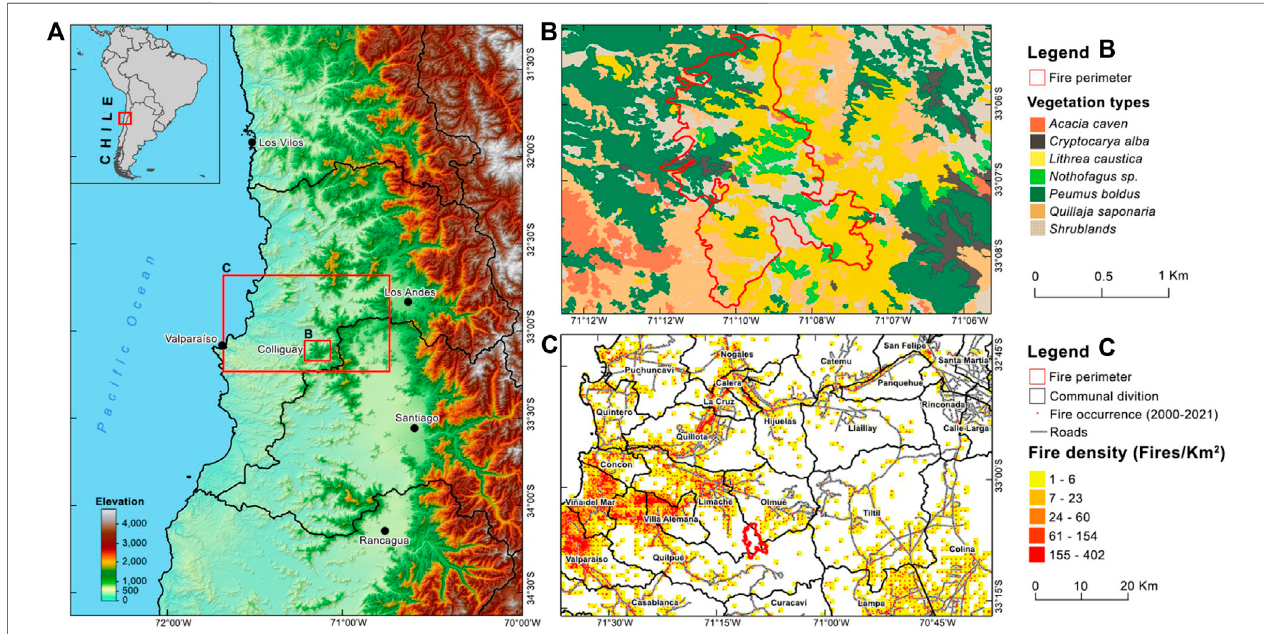
FIGURE1| Studyarea. (A) CentralChileandthegenerallocationoftheColliguaywild fi re(redpolygon)wheretheproposedapproachisapplied; (B) speci fi careaof the Colliguay wild fi re and vegetation types before the event(May 2020); (C) context ofhigh density ofwild fi res in thesurrounding areas oftheColliguay wild fi re in Central